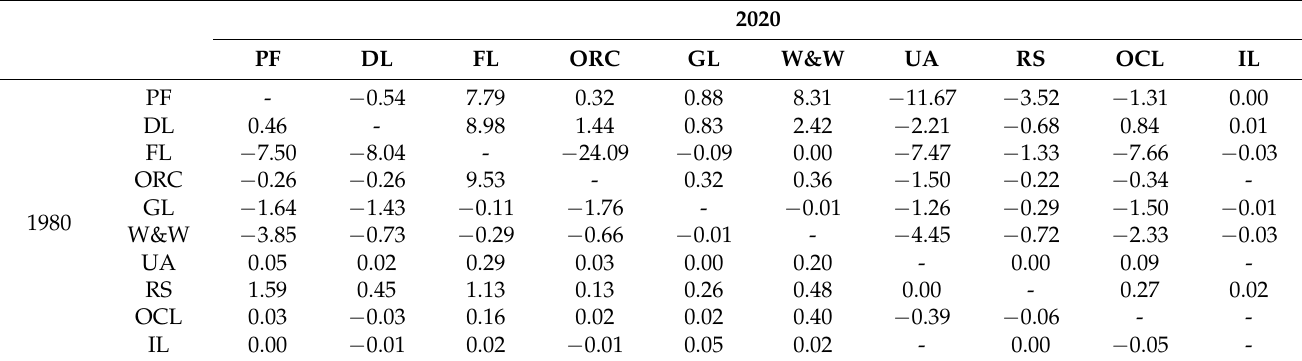
Table 4. The CIs of land use change to habitat quality from 1980 to